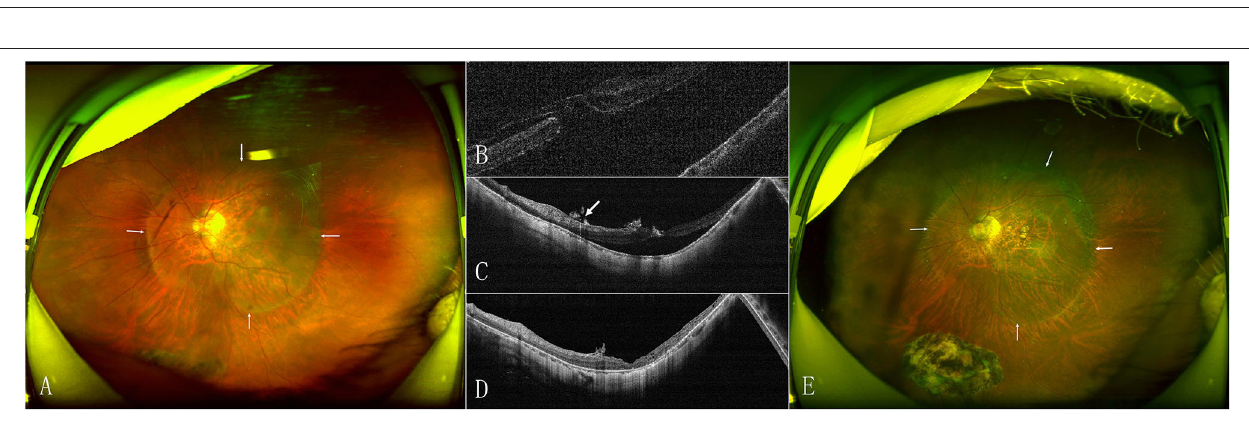
FIGURE 2 | Preoperative and postoperative SLO and OCT images of the eye of a 59-year-old woman with MHRD in the face-down positioning group. (A) Preoperative SLO shows that the MHRD beyond vascular arcade to the edge of posterior staphyloma (arrow). (B) Preoperative OCT confirms the MH. (C) OCT at 12 months after surgery shows that the MH is closed and subretinal fluid in the macular region has not been absorbed (white arrow showing the silicone oil emulsification). (D) Twenty seven months later, OCT shows the subretinal fluid is absorbed completely. (E) Postoperative SLO at 27 months shows reattached retina and posterior staphyloma